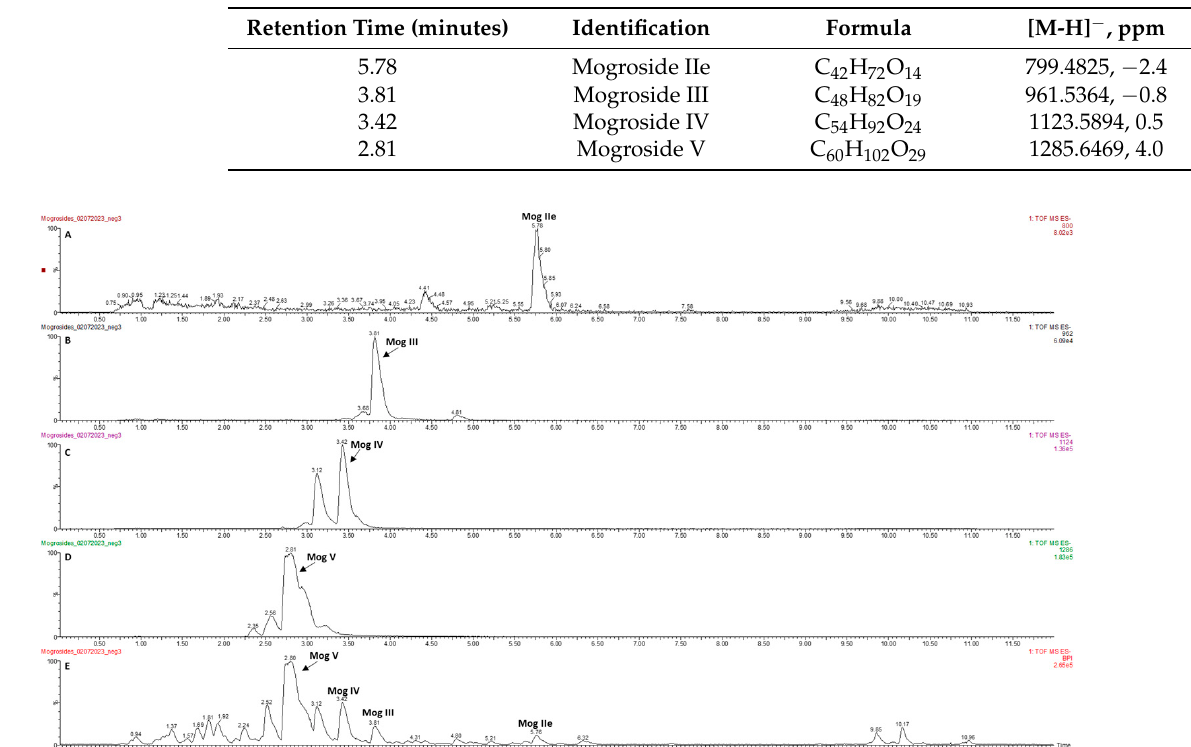
Figure 1. LC-MS base peak intensity extracted ion chromatograms at 800 m / z mogroside IIe ( A ), 962 m / z mogroside III ( B ), 1124 m / z mogroside IV ( C ), 1286 m / z mogroside V ( D ), total ion chromato- gram ( E ). Table 1. LC-MS i dentification of Mogrosides.